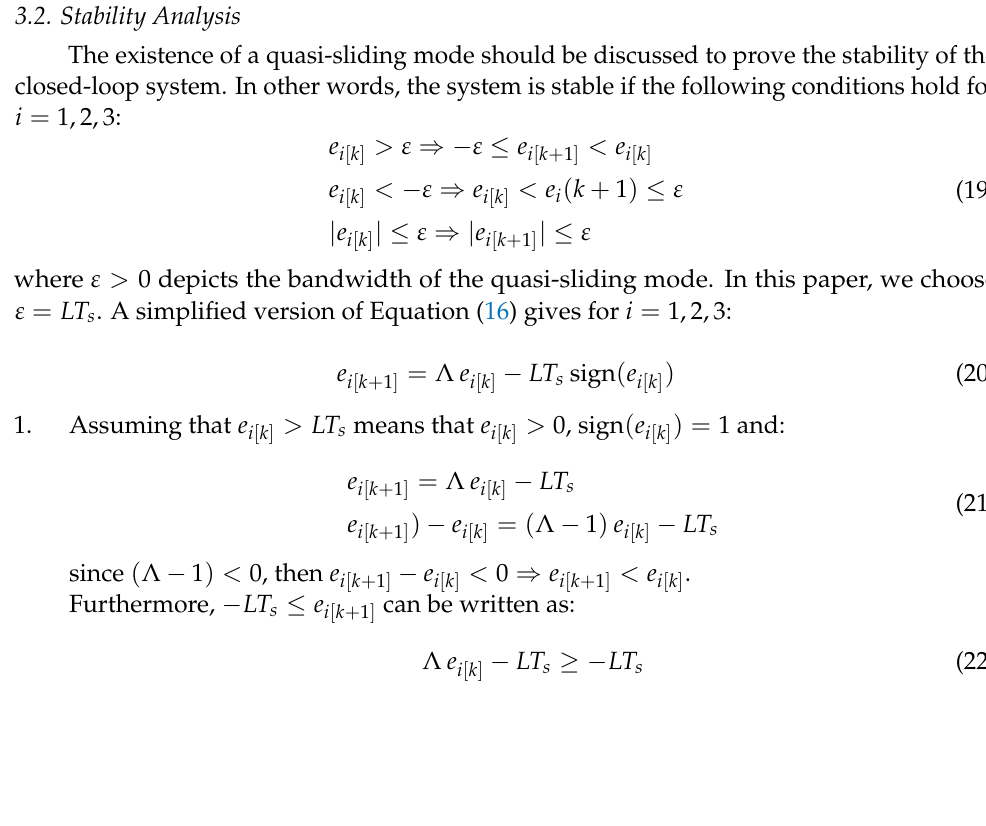
Figure 2. Block diagram of the DTSM current control